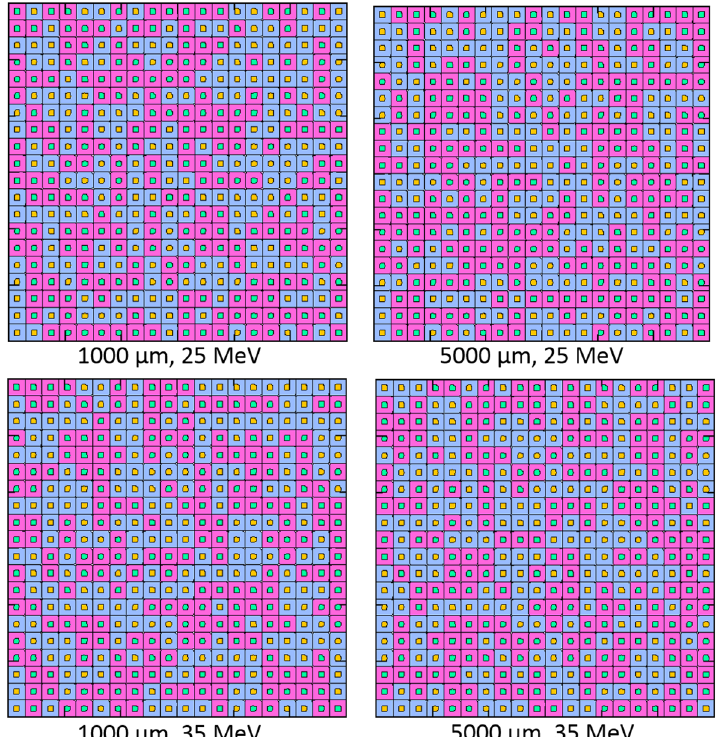
Figure 9. Examples of random boron distribution in the generated cell array below 1000 and 5000 µm buffer media irradiated by protons with incident energies of 25 and 35 MeV. (Blue and pink represent normal and boron filled cytoplasm, respectively. Orange and green represent normal and boron filled cell nucleus,